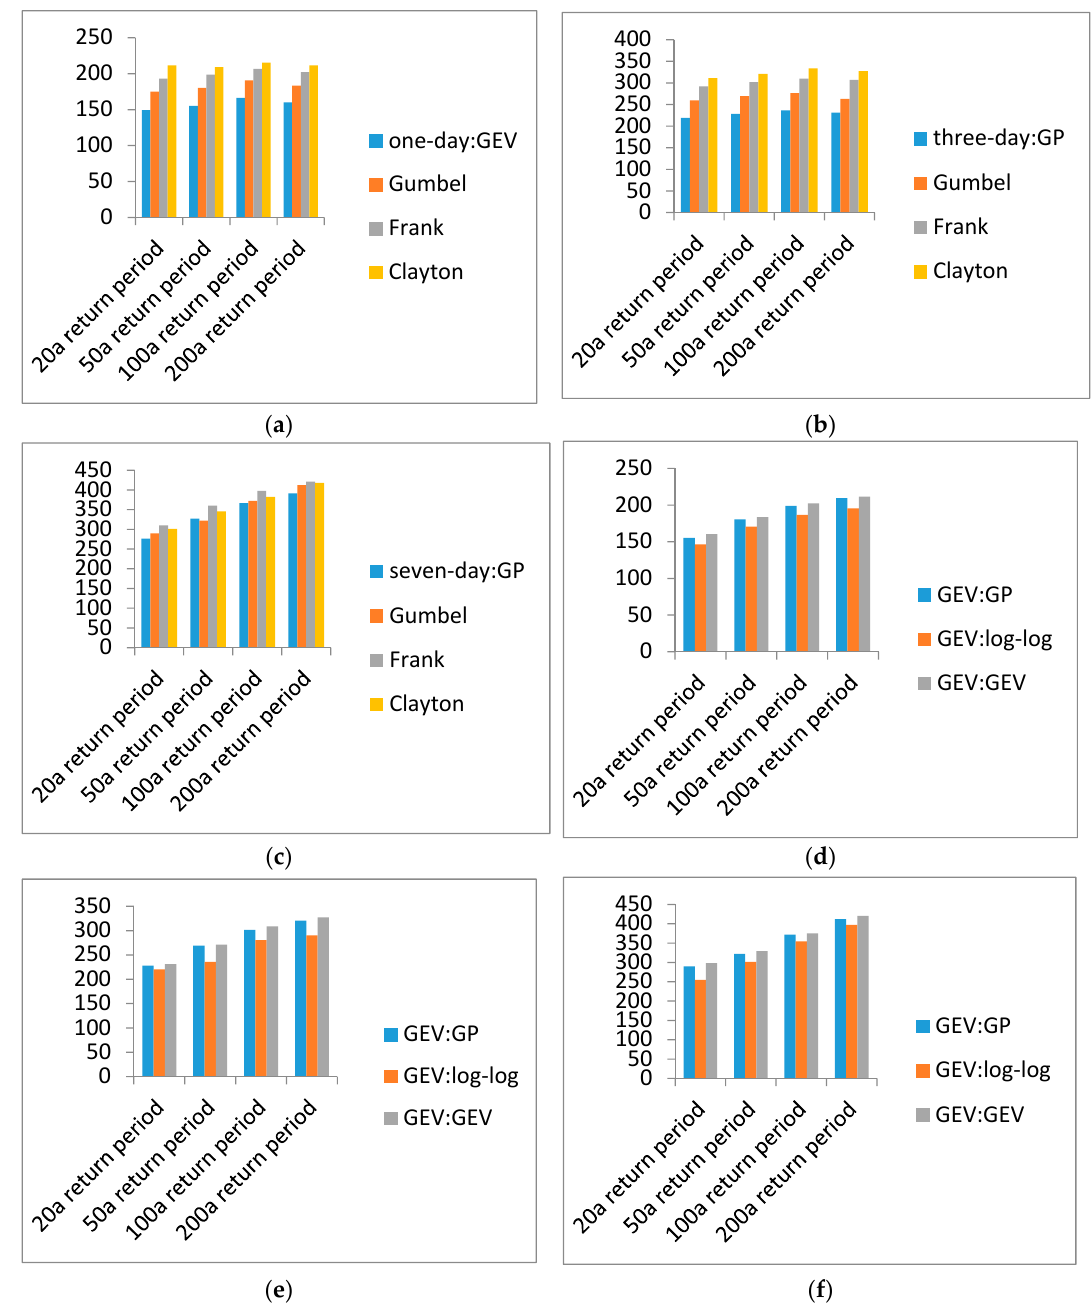
Figure 7. Design values for a single variable and two-dimensional copula joint distributions. ( a ) GEV (one-day) vs. copulas (one-day); ( b ) GP (three-day) vs. copulas (three-day); ( c ) GP (seven-day) vs. copulas (seven-day); ( d ) one-day rainfall of Gumbel using different marginal distributions; ( e ) three-day rainfall of Gumbel using different marginal distributions; ( f ) seven-day rainfall of Gumbel using different marginal distributions.